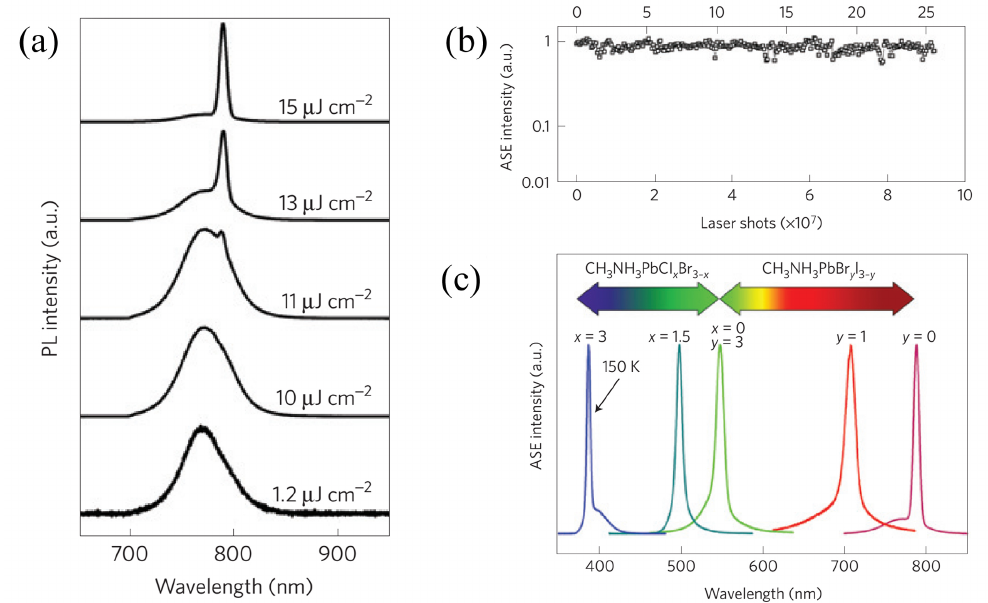
Figure 1. ( a ) Excitation density dependence of the PL spectra of a MAPbI 3 thin film, showing evidence for the appearance of the ASE band for excitation densities above 11 µ Jcm − 2 . ( b ) MAPbI 3 ASE intensity operational stability under continuous pumping at 11 µ Jcm − 2 . ( c ) ASE color tunability as a function of the film chemical composition. Adapted with permission from [4]. Nature Publishing group,